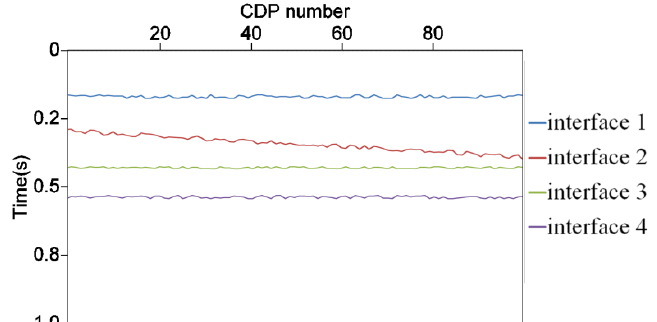
Figure 10. Result of tracking paths.